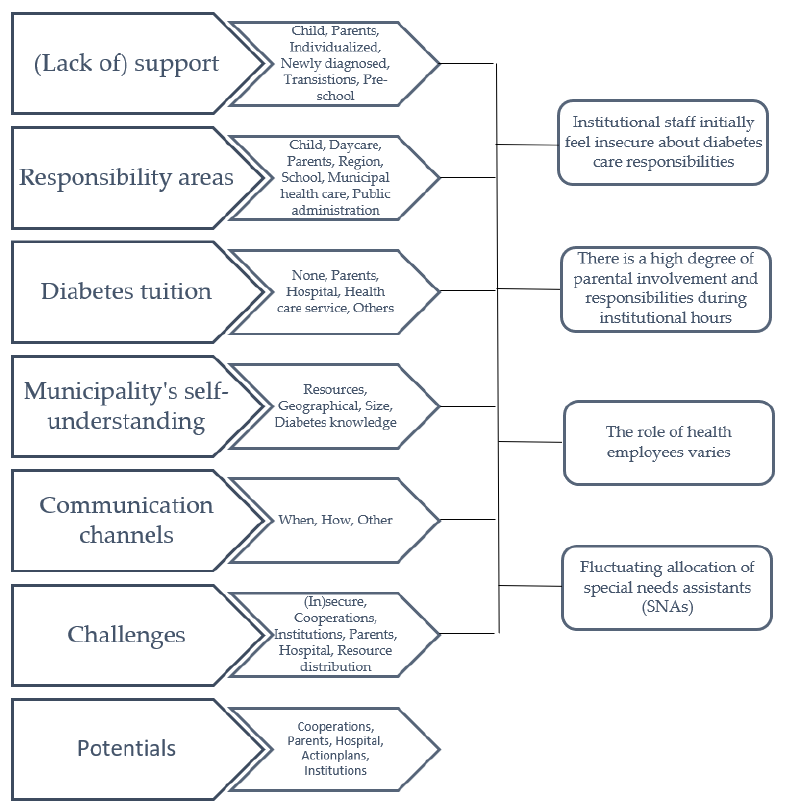
Figure 1. An overview of the code groups, subgroups and four main categories.